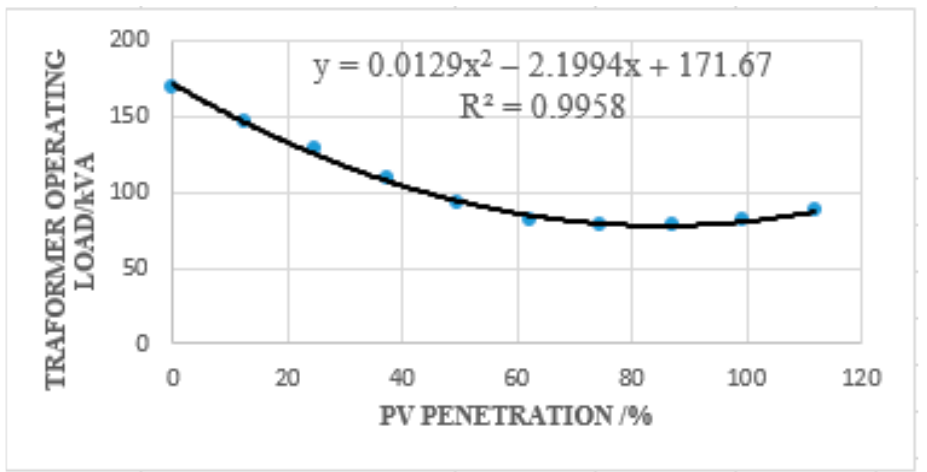
Figure 4. Graphical analysis of transformer kVA loading.